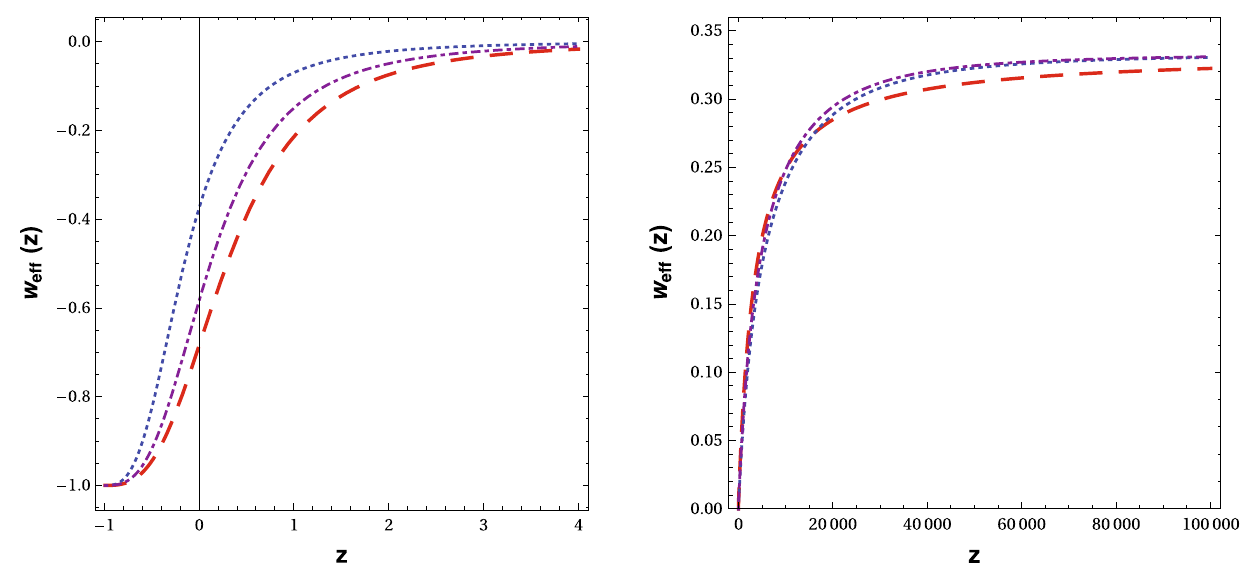
Fig. 1 The dotted and dot-dashed lines represent our model for χ 2 + χ 2 + χ 2 χ 2 best fits, respectively, based on the results from l 1 BAO SNIa Sect. 4. The dashed one represents the (cid:3) CMD model. On the left, we plot w ef f ( z ) for small values of z and in the right plot there are higher